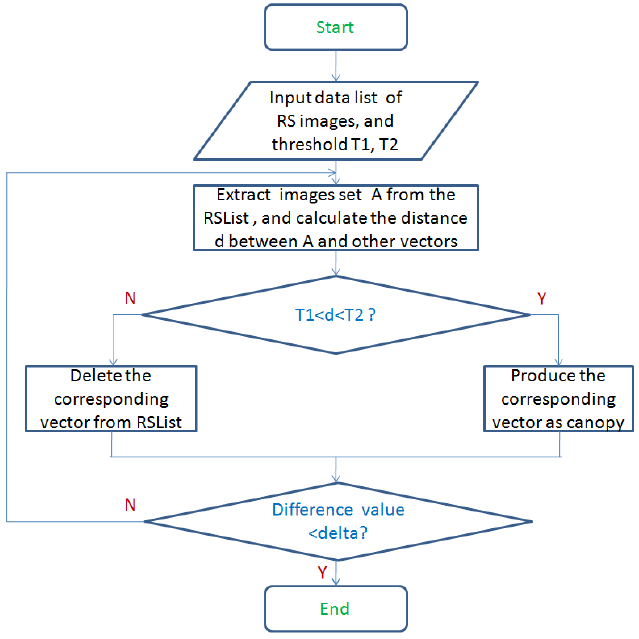
Figure 5. Flow of creating